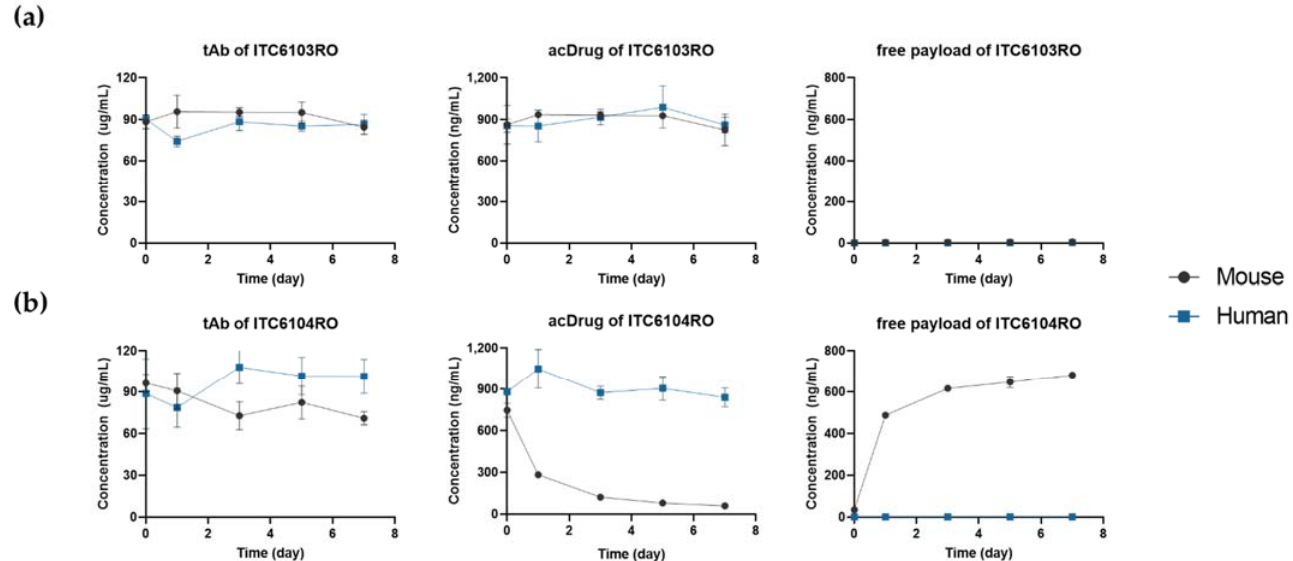
Figure 2. Time-concentration profiles of total antibody (tAb), antibody-conjugated drug (acDrug) and free payload for ( a ) ITC6103RO and ( b ) ITC6104RO from in vitro linker stability in mouse and IgG depleted human plasma.